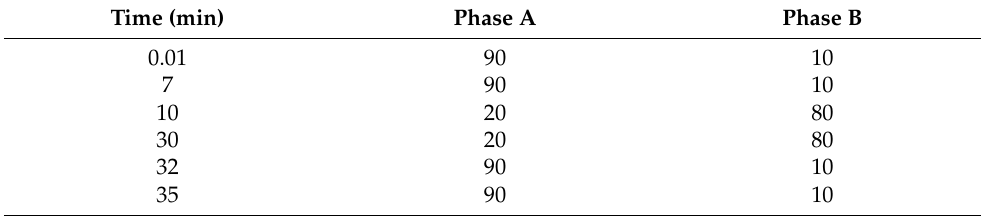
Table 2. Gradient elution used for PhACs quantification by HPLC